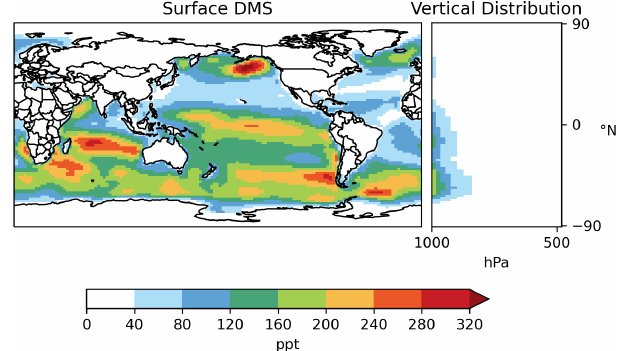
Figure 7. Horizontal distribution of annual mean surface mixing ratio and zonal mean vertical distribution of DMS (both in parts per trillion – ppt) modeled by